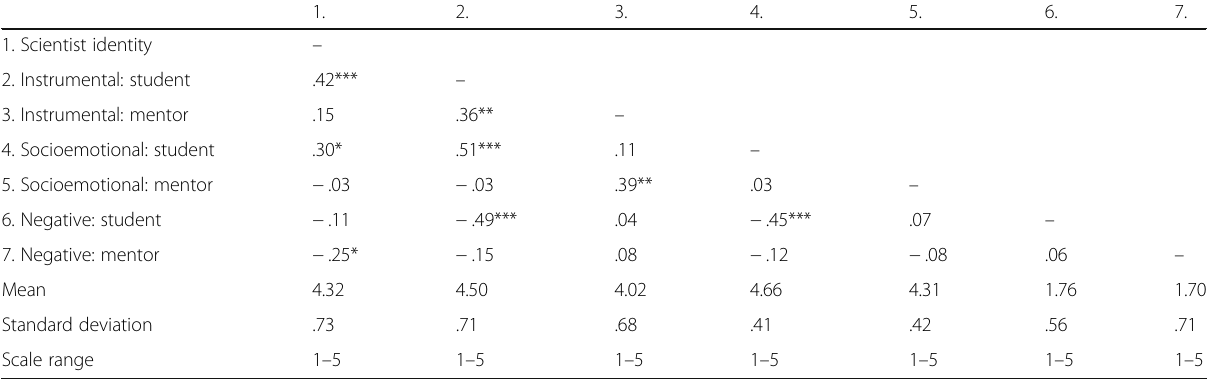
Table 1 Descriptive statistics and correlation matrix for scientist identity and mentoring variables 1.